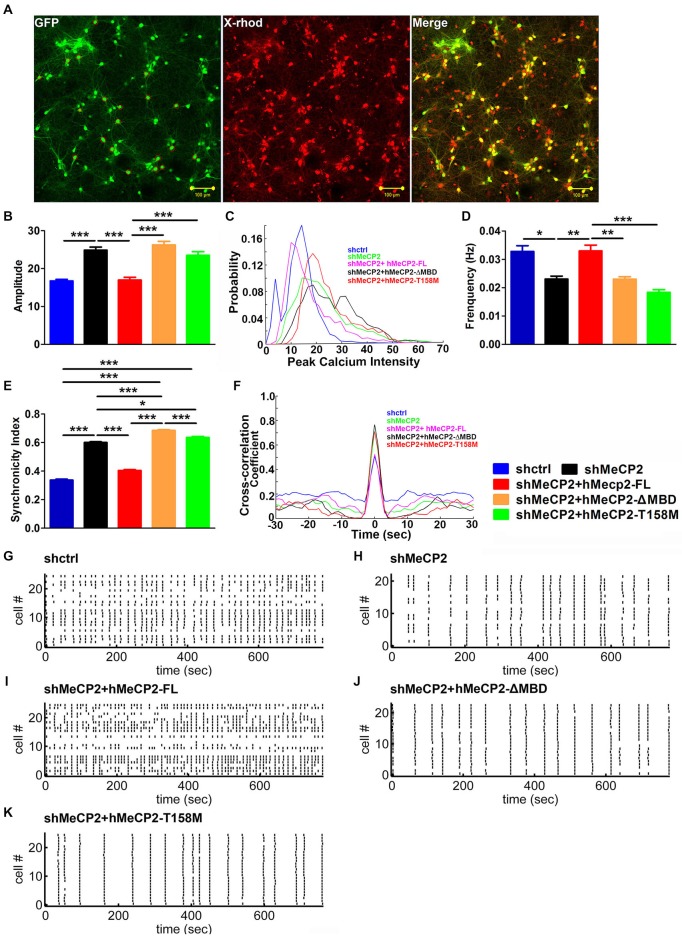
MeCP2 regulates spontaneous calcium oscillations in primary hippocampal neurons. (A) Representative images of neurons pre-infected with different kind of virus (green) and stained with X-Rhod-1 (red) (scale bar = 100 μm). (B–F) Graph shows the amplitude of calcium oscillations (B), the distribution probability of amplitude (C), the frequency (D) and the synchronicity index (E) as well as the cross-correlation coefficient (F) of calcium oscillations in neurons infected with the indicated constructs. (G–K) Representative Spike Raster Plot of the different groups of neurons as indicated, showing calcium spikes from >20 neurons/plot over a time period of 800 s as indicated on the X-axis. (*p < 0.05, **p < 0.01 and ***p < 0.001, one-way ANOVA with a post hoc Tukey multiple comparison, n = 120 neurons from at least 3 batches).